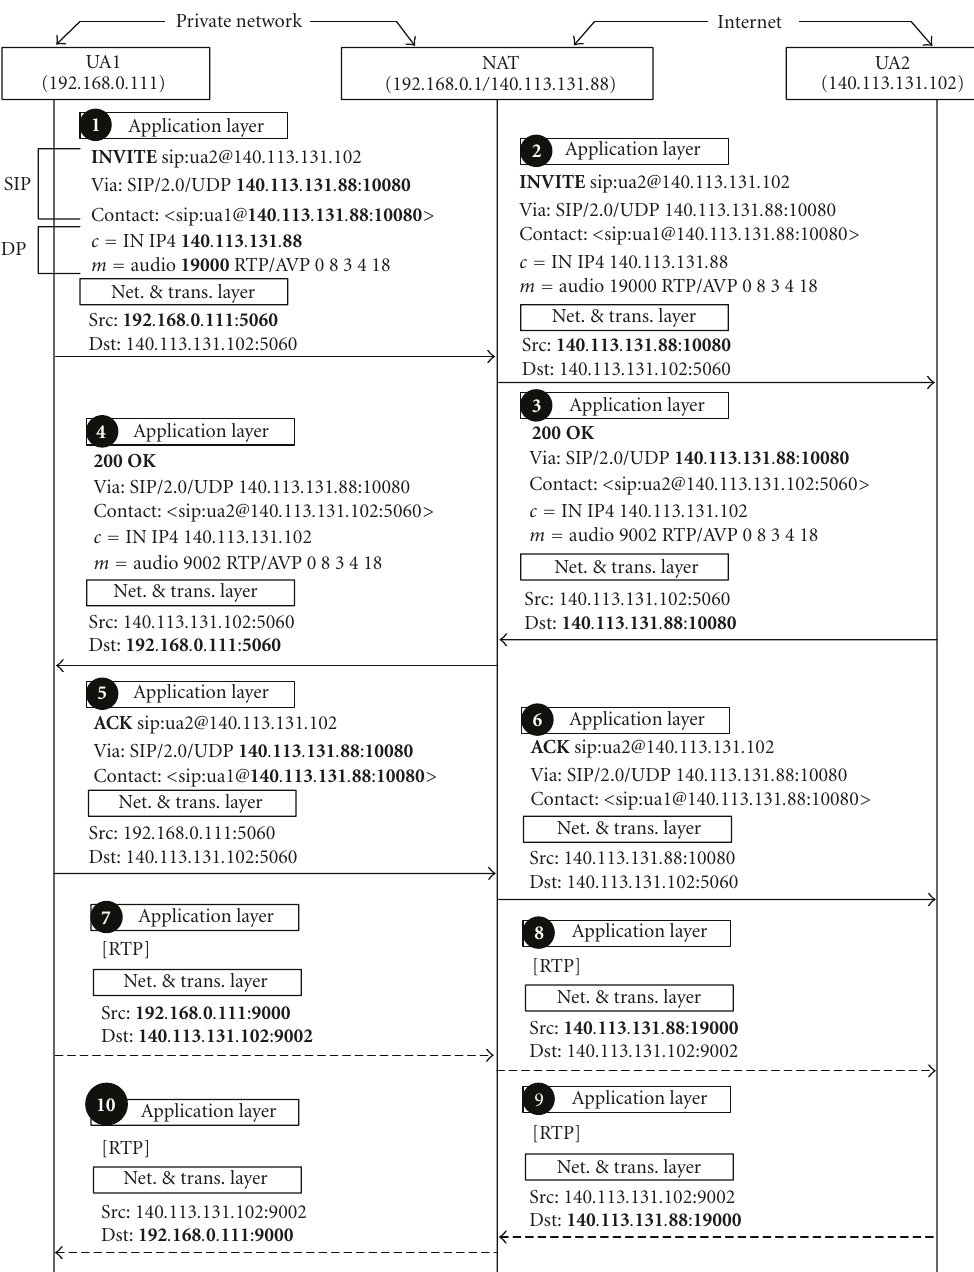
Figure 2: SIP/RTP NAT traversing: the static route